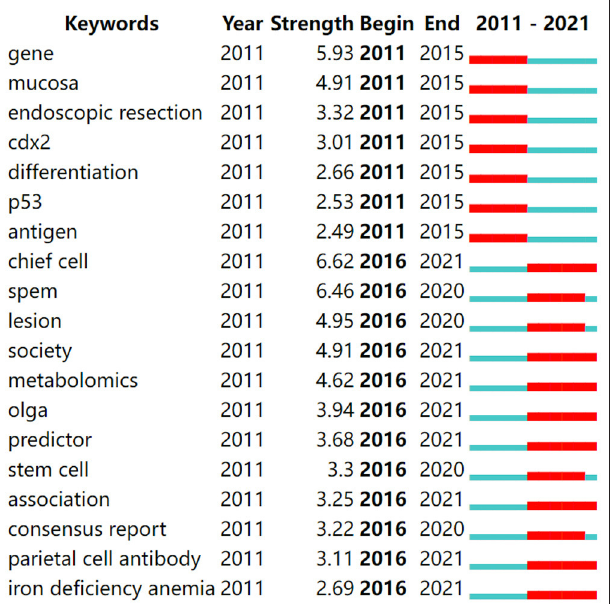
FIGURE 9 | Top 19 keywords with strong citation bursts in AG research.